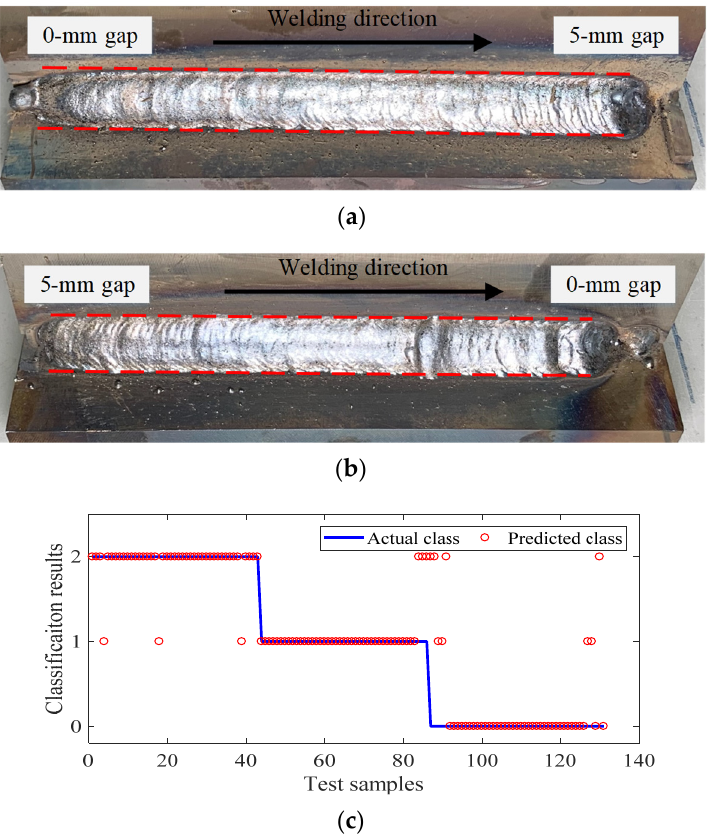
Figure 15. Online weld gap monitoring and robot control results (applied robot motion 3): ( a ) weld bead shape of linearly increasing gap regions (without robot control), ( b ) weld bead shape of linearly decreasing gap regions (with robot control), and ( c ) real-time weld gap monitoring results. Table 8. Real-time weld gap detection performance of the proposed DNN model (increasing gap). Variable Support Correctly Estimated Error